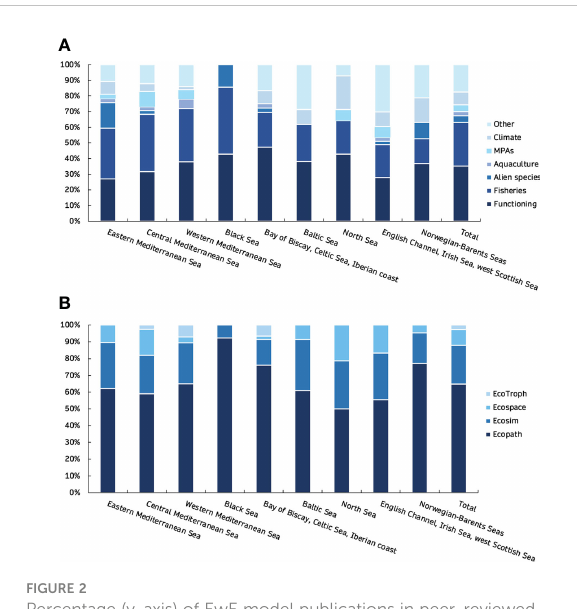
FIGURE 2 Percentage (y-axis) of EwE model publications in peer-reviewed journals classi fi ed by topic (A) and by EwE module (B) for the nine European marine regions.